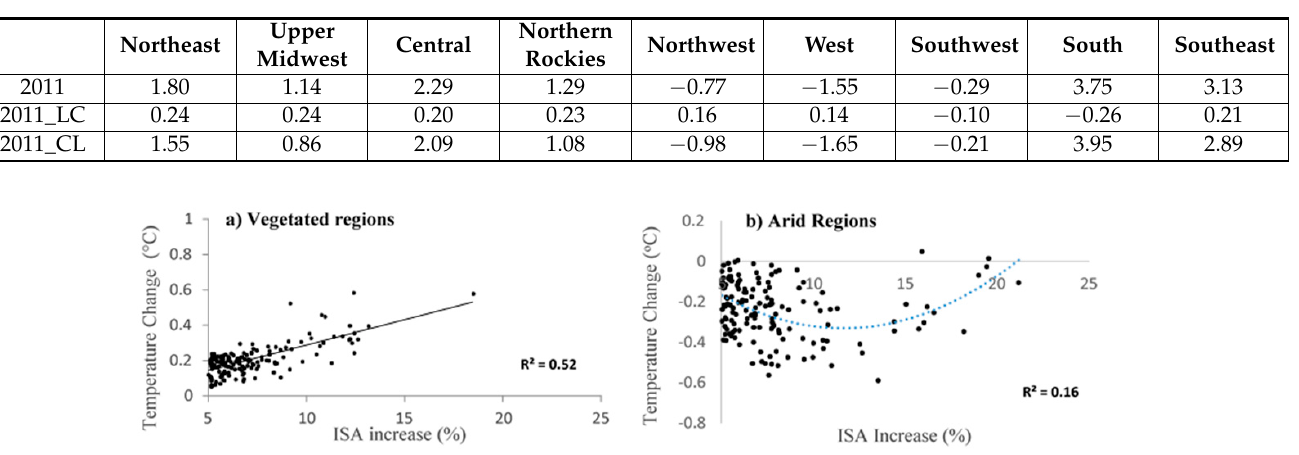
Table 2. Regional summer (June-July-August) 2011 mean temperature change ( ◦ C) compared to 2001.